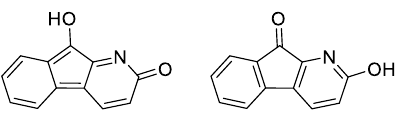
Figure 5. Tautomers of 10a .